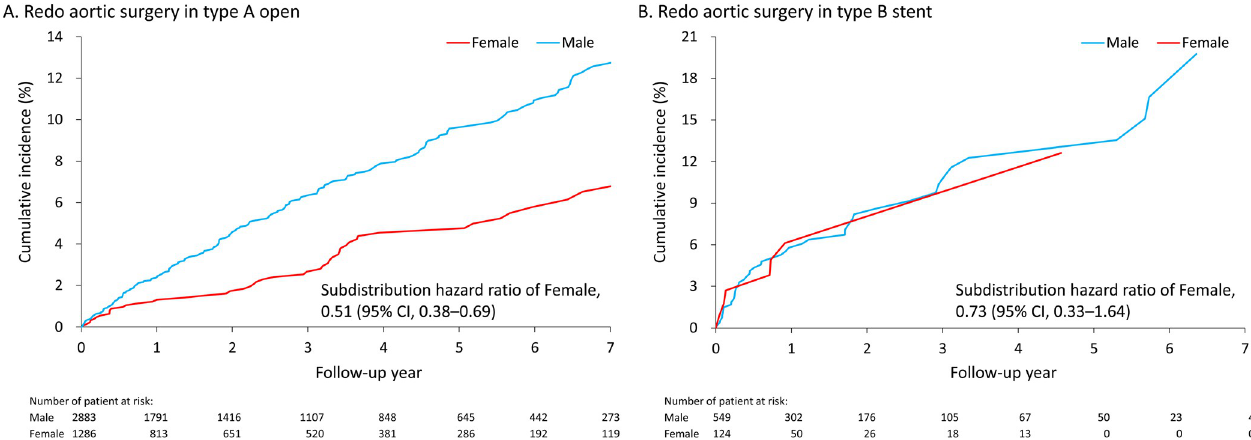
Fig 2. The cumulative incidence function of redo aortic surgery in the female and male patients who received type A open surgery (A) and type B stent surgery (B) by using the raw data for real-world practice. The subdistribution hazard ratio was not adjusted for any covariates.